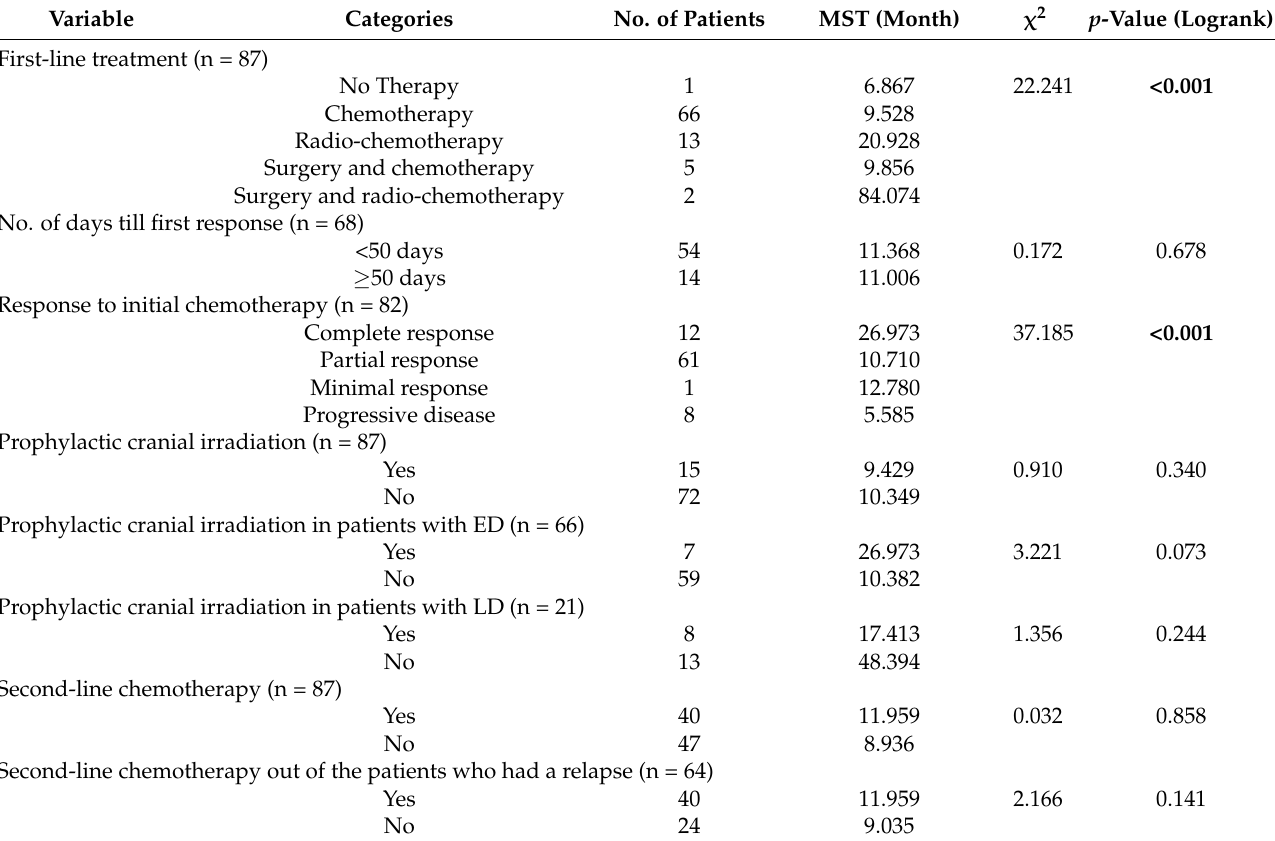
Table 3. Univariate analysis of therapy parameters at baseline.